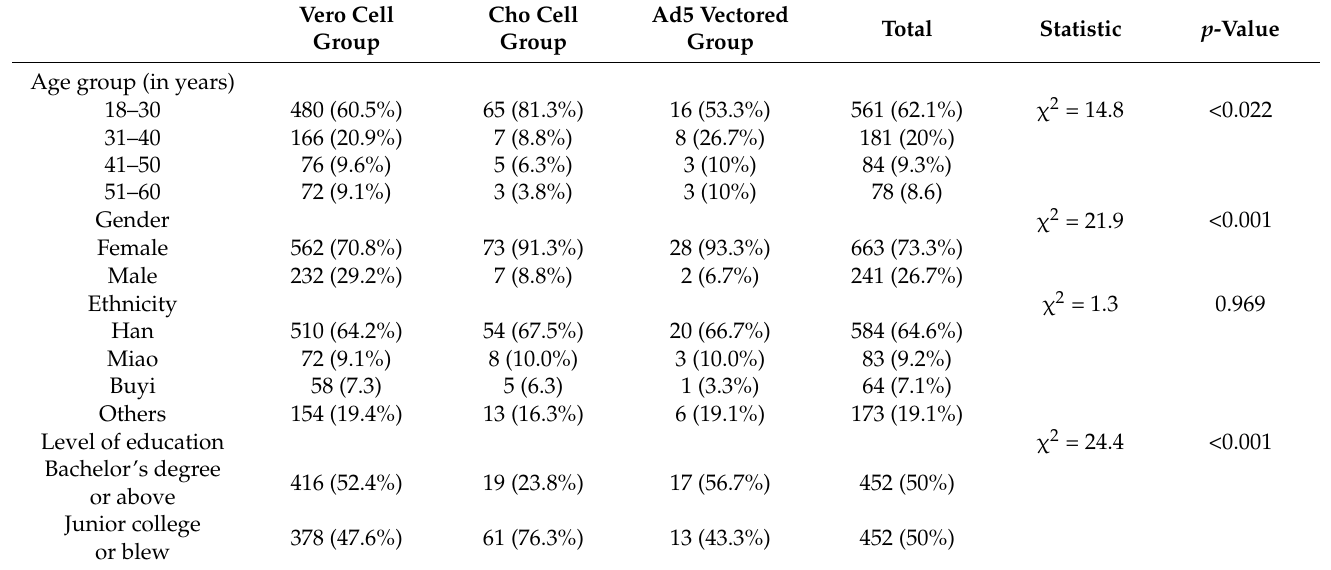
Table 1. Demographic data for the study participants who received one of the three types of COVID- 19 vaccine.